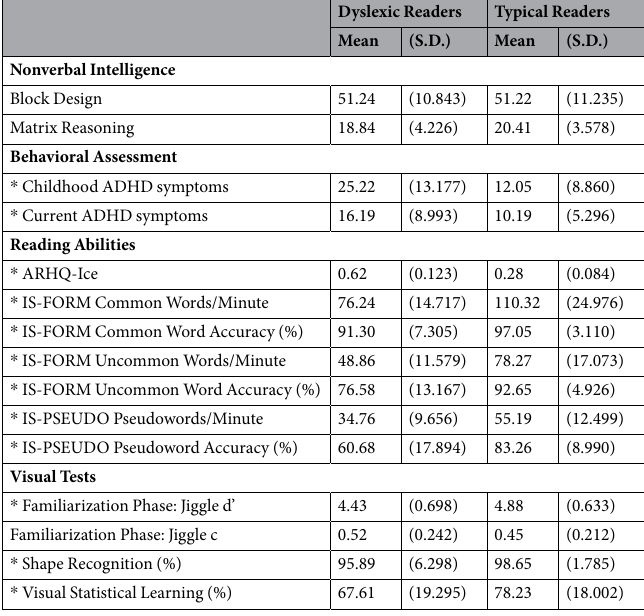
Table 1. Descriptive statistics for dyslexic and typical readers. Significant differences (independent samples t-tests) between dyslexic and typical readers are marked with an asterisk ( *